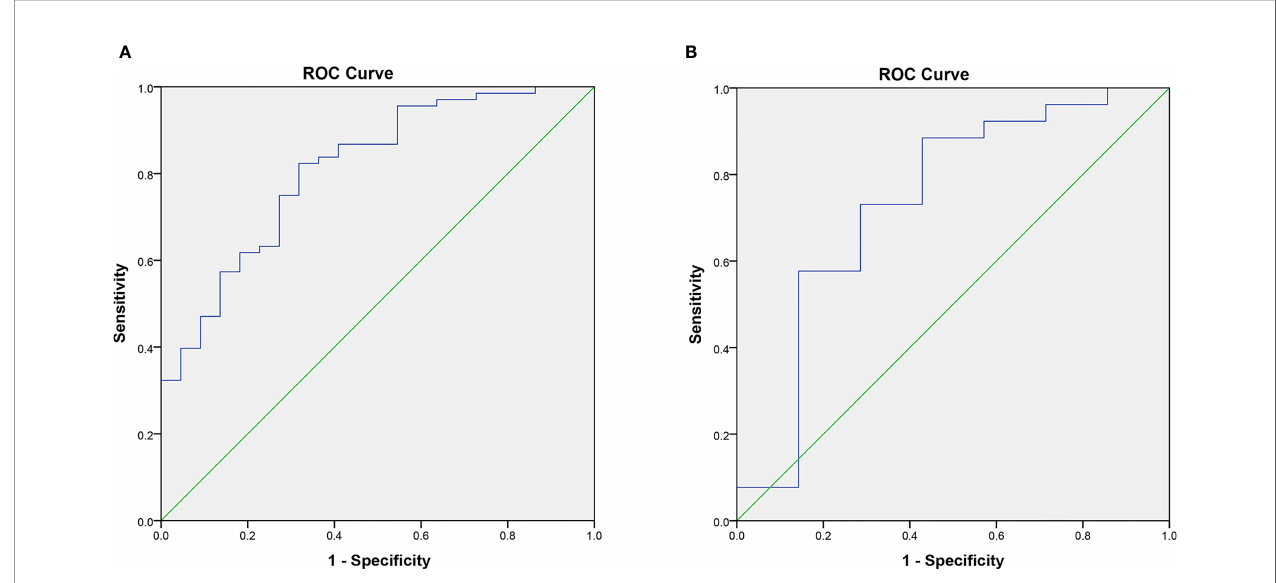
FIGURE 6 | The AUC of the B-US radiomics model in the training cohort (A) and validation cohort (B) .